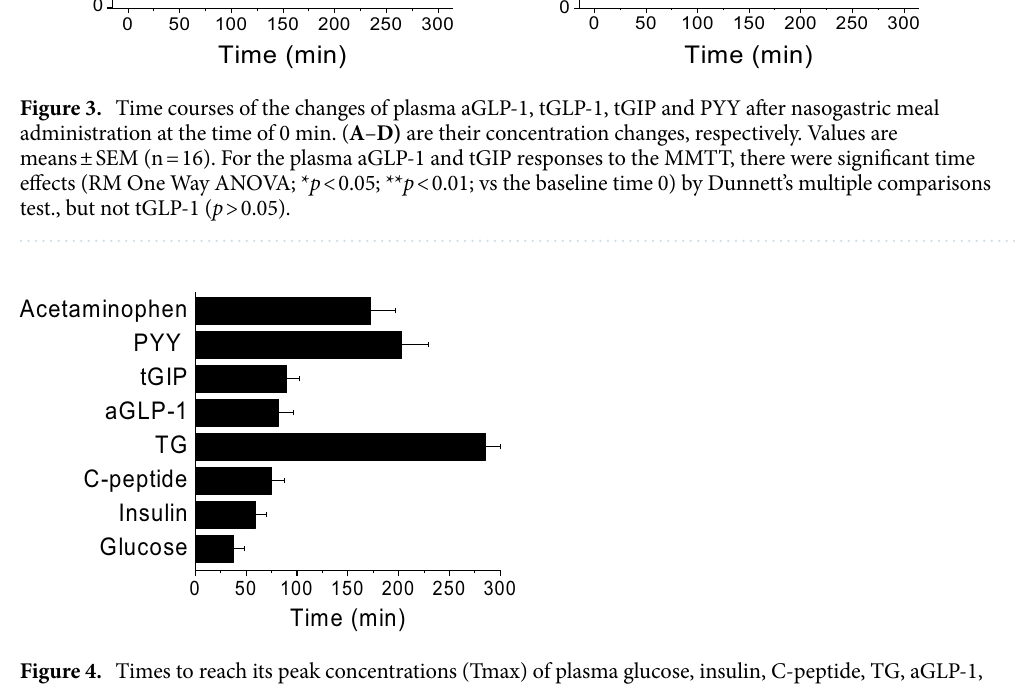
Figure 4. Times to reach its peak concentrations (Tmax) of plasma glucose, insulin, C-peptide, TG, aGLP-1, GIP, PYY and acetaminophen after nasogastric meal administration at the time of 0 min. Tmax was calculated according to the time reaching the peak concentration of each parameter in individual animal. Values are means ± SEM (n = 16). As TC, LDL and tGLP-1 did not show their obvious peaks during MMTTs, their Tmaxs were not calculated and